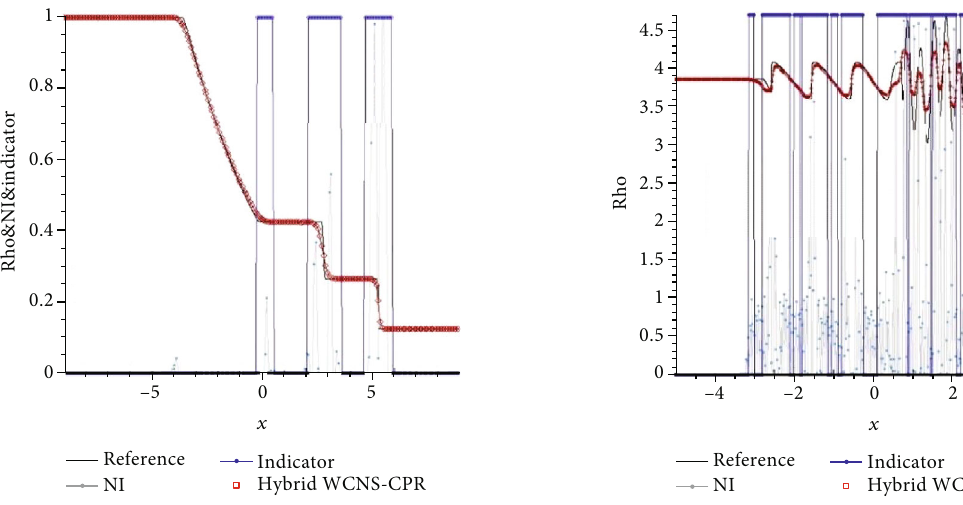
Figure 8: Density numerical solution and shock detection result of the hybrid WCNS-CPR scheme for the 1D Sod problem.